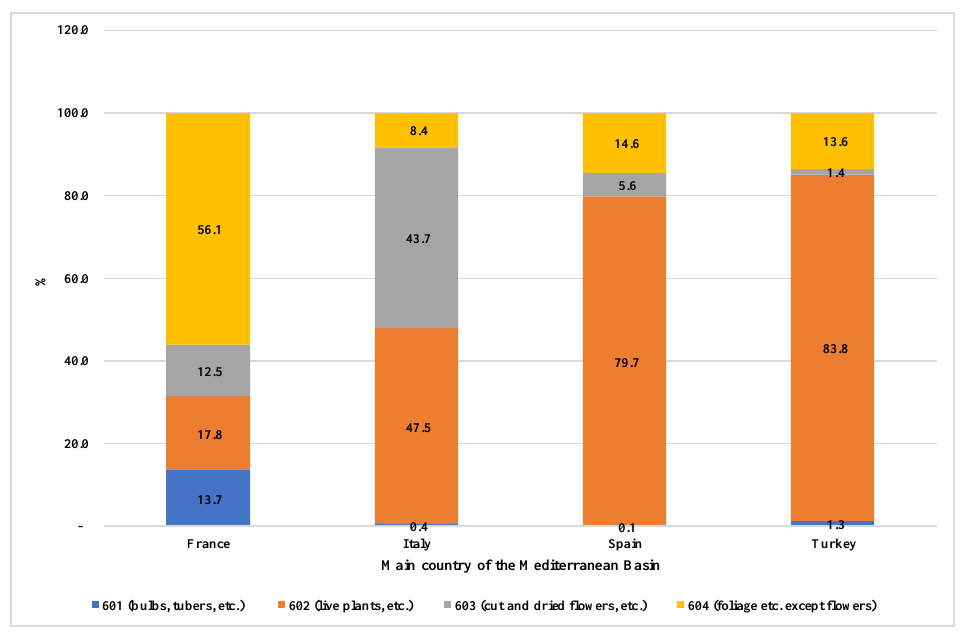
Figure 5. Percent of imports into Mediterranean countries of plant materials for non-food use from countries at risk (UN Trade Code 06) by subcode in 2018.